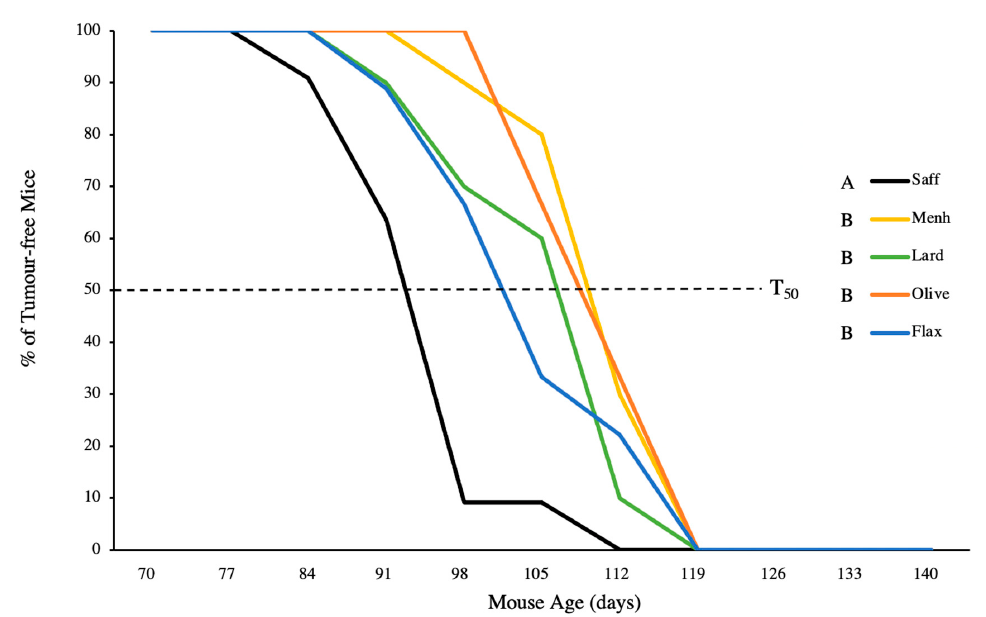
Figure 2. Proportion of mice that remained tumour free over the 20-week experimental period fed either 10% safflower oil diet ( n = 11), 3% menhaden oil diet ( n = 10), 3% flaxseed diet ( n = 9), 10% olive oil diet ( n = 6), or 10% lard diet ( n = 10). T50 denotes the time at which 50% of mice in a given group developed tumours. Groups with a different letter are significantly different as determined by repeated measures analysis ( p < 0.05).